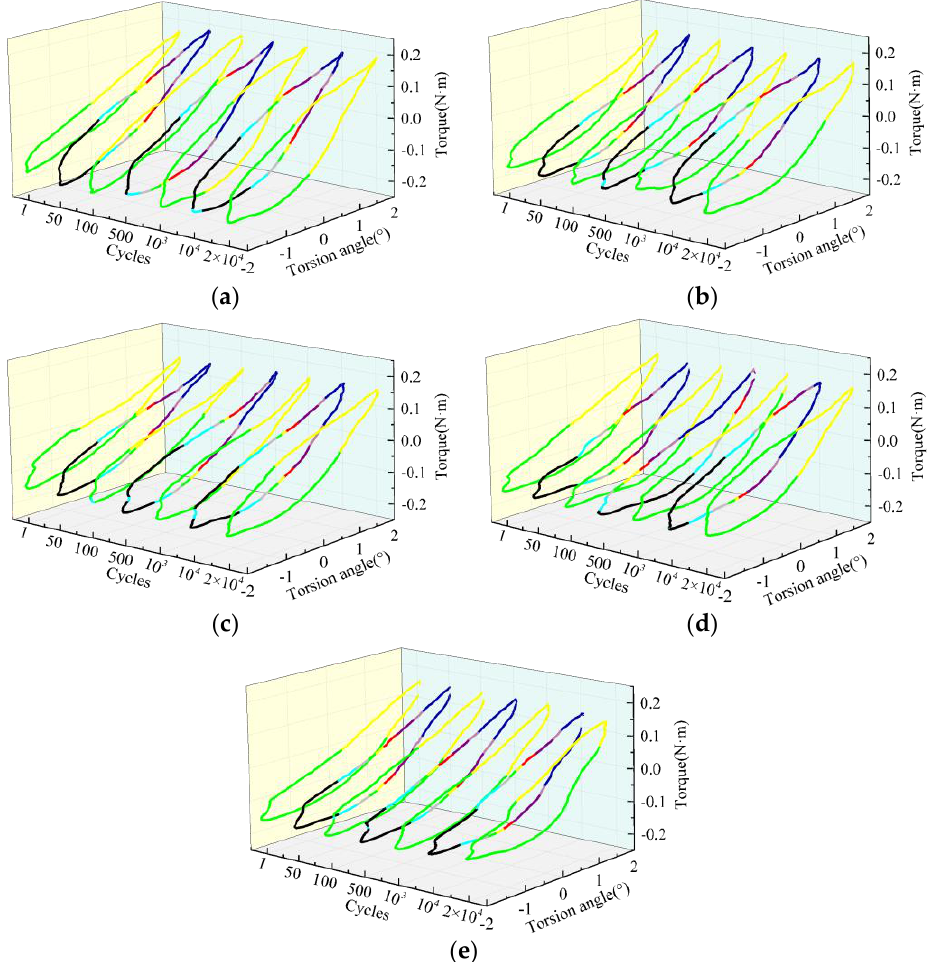
Figure 2. Hysteresis loops of torque versus torsion angle during tension–torsion cyclic loading of steel wires with fretting contact in different environmental media. ( a ) Air. ( b ) Acid solution. ( c ) Neutral solution. ( d ) Alkaline solution. ( e ) Deionized water.